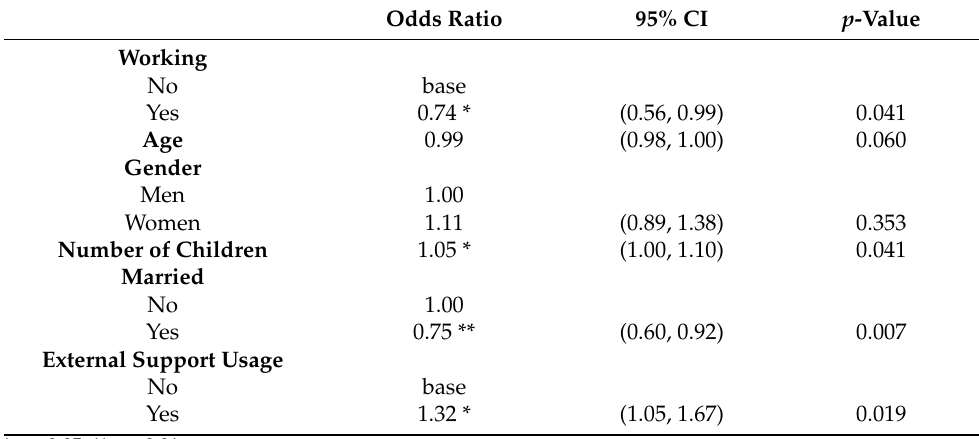
Table 3. Logistic Regression Predicting Spending Increase during COVID-19.